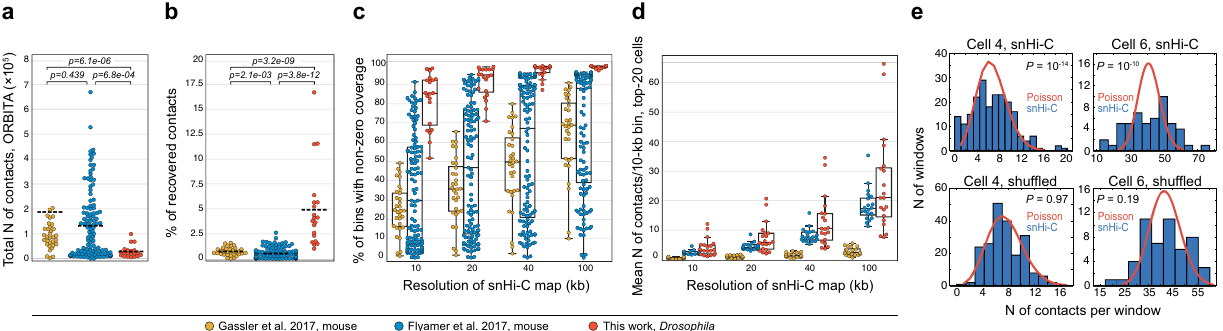
Fig. 2 snHi-C datasets in Drosophila represent a major portion of the genome and are not random matrices. a Number of ORBITA-captured contacts per individual nuclei obtained for Drosophila in the current work, compared with mouse oocytes from Flyamer et al. 32 and G2 zygotes pronuclei from Gassler et al. 34 . ** p < 0.01 using the Mann – Whitney two-sided test. n = 20, 120, and 32 nuclei for Drosophila in the current work, mouse oocytes from Flyamer et al. 32 and G2 zygotes pronuclei from Gassler et al. 34 , respectively (the same is true for ( b ) and ( c )). b Percentage of recovered contacts out of the total possible for Drosophila in the current work, compared with mouse oocytes from Flyamer et al. 32 and G2 zygotes pronuclei from Gassler et al. 34 . P -values are calculated using the Mann – Whitney two-sided test. c Percentage of bins with non-zero coverage for autosomes and sex chromosome of Drosophila , murine oocytes, and G2 zygote pronuclei. Boxplots represent the median, interquartile range, maximum and minimum. d Mean number of contacts per 10-kb genomic bin in top-20 cells in the current work, compared with mouse oocytes from Flyamer et al. 32 and G2 zygotes pronuclei from Gassler et al. 34 . Boxplots represent the median, interquartile range, maximum and minimum. e Distributions of the number of contacts in windows of fi xed size (100 kb for the Cell 4, and 400 kb for the Cell 6; chr2R) in snHi-C data and shuf fl ed maps for two individual cells (blue bars). The red curve shows the Poisson distribution expected for an entirely random matrix with the same number of contacts. P- values were estimated by the goodness of fi t test. n = 211 and 52 windows for the cell 4 and for the cell 6,